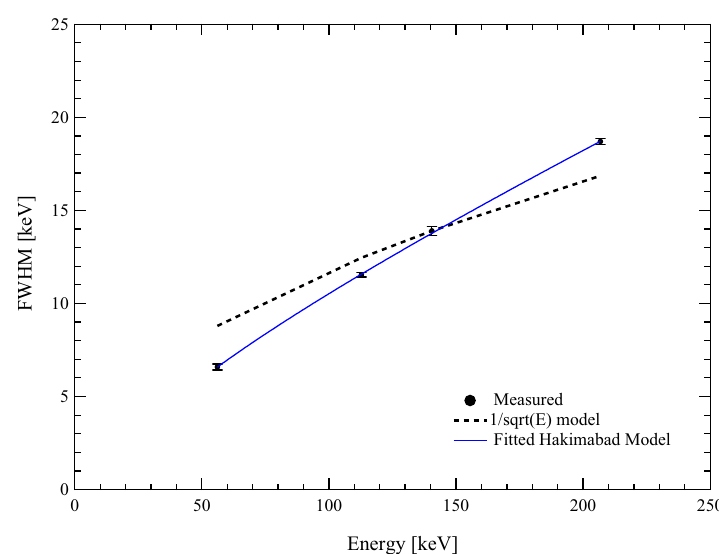
Fig. 8 Gamma camera energy resolution. Comparison between the measured and calculated gamma camera energy resolution using two models